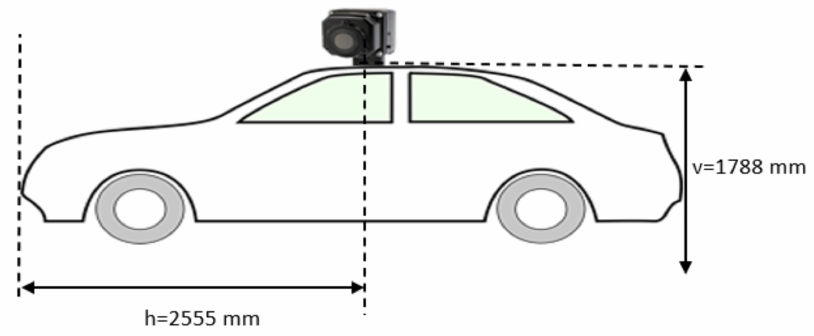
Figure 1. Camera position and mounting on the